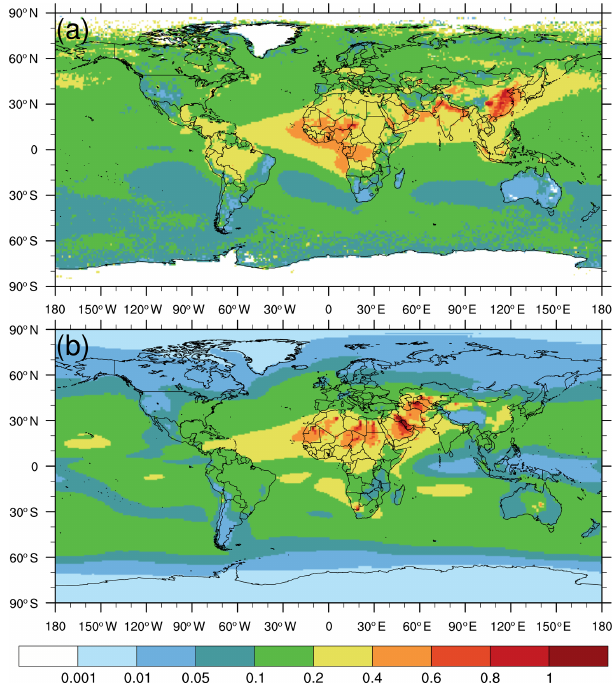
Figure 1. Comparison of annual average column AOD at 550nm from (a) MODIS aboard the Aqua satellite (2003–2010); (b) CAM5 simulation averaged from 2001 to 2010.